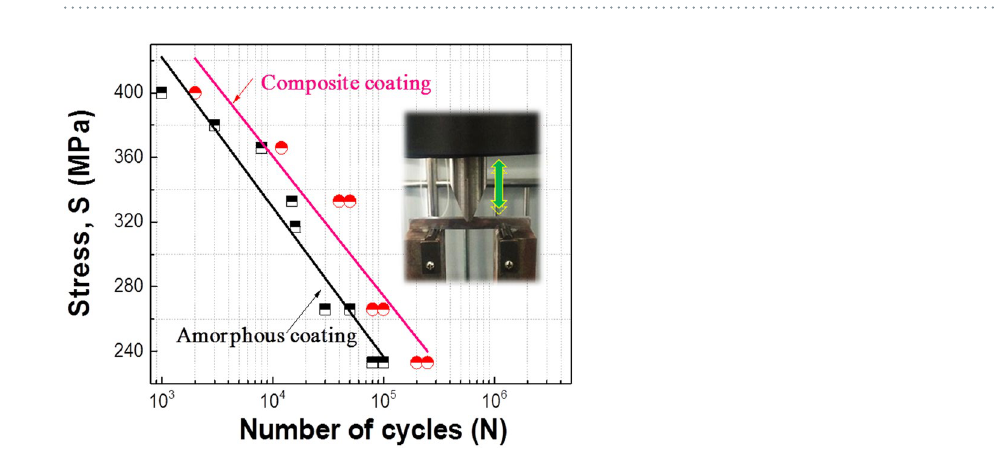
Figure 5. ( a ) Stress-displacement curves obtained from three-point bending tests for the amorphous coating and the composite coating. Insets show a schematic diagram for this test and an enlarged region for amorphous coating showing the fracture of the coating. ( b–g ) Real-time optical photographs obtained during static three- point bending test, showing the crack behaviors in ( b,c ) the amorphous coating and ( d–g ) the composite coating at different loading duration.